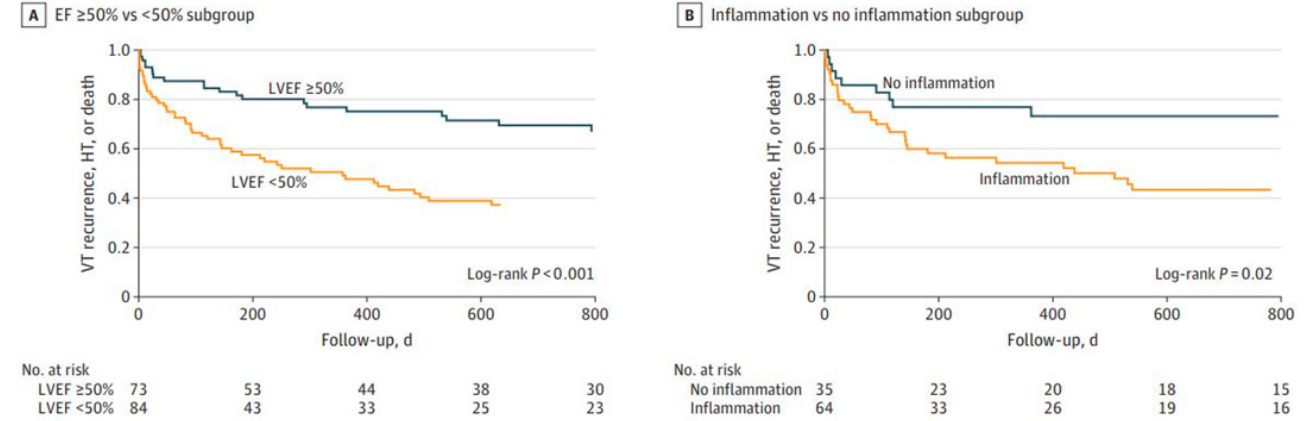
Figure 2. Outcomes of VT ablation in CS stratified by baseline ( A ) LVEF ≥ 50% vs. <50% and ( B ) presence vs. absence of active myocardial inflammation. Kaplan–Meier survival curves for the composite outcome of VT recurrence, heart transplant, or death. Reproduced with permission from Siontis et al. [42].